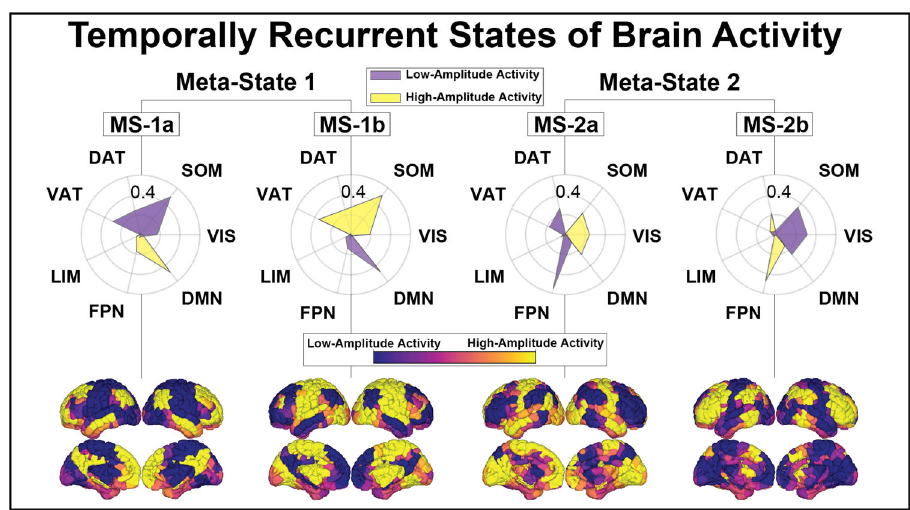
Fig. 2 | Recurrent states of brain activity. Group average recurrent brain states are represented by the mean activation pattern across all subjects and conditions for each of the 4 clusters (brain representations at the bottom of the fi gure). For each brain state, we separately calculated the cosine similarity (radial plots) of its high-amplitude (supra-mean) activity and low-amplitude (sub-mean) activity to a priori resting-state networks 91 (RSNs); resulting similarity measures are repre- sented via radial plots 29 . Meta-State 1 (MS-1) is composed of two sub-states (MS-1a andMS-1b)whicharecharacterizedbythecontrapositionofthesomatomotorand ventral attention/salience networks with the default-mode network, whereas the